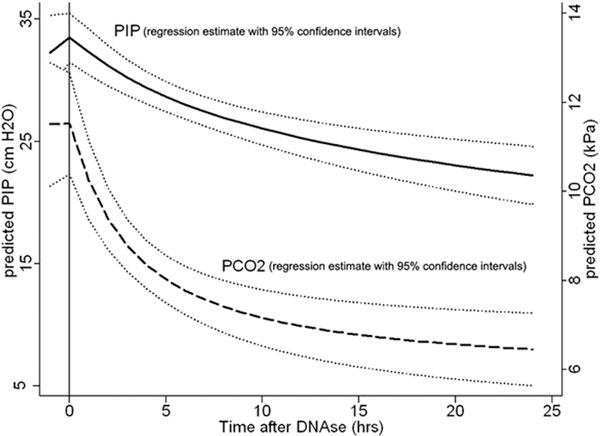
Fractional polynomial regression of PIP/PCO2 following DNAse.